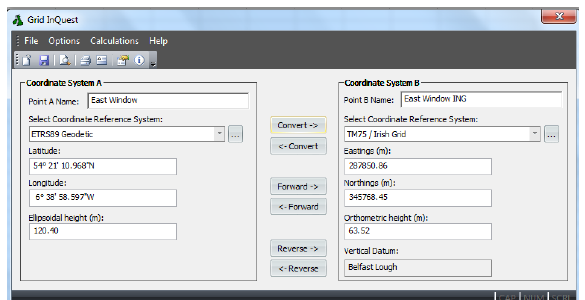
Figure 7: Grid Inquest for coordinate system